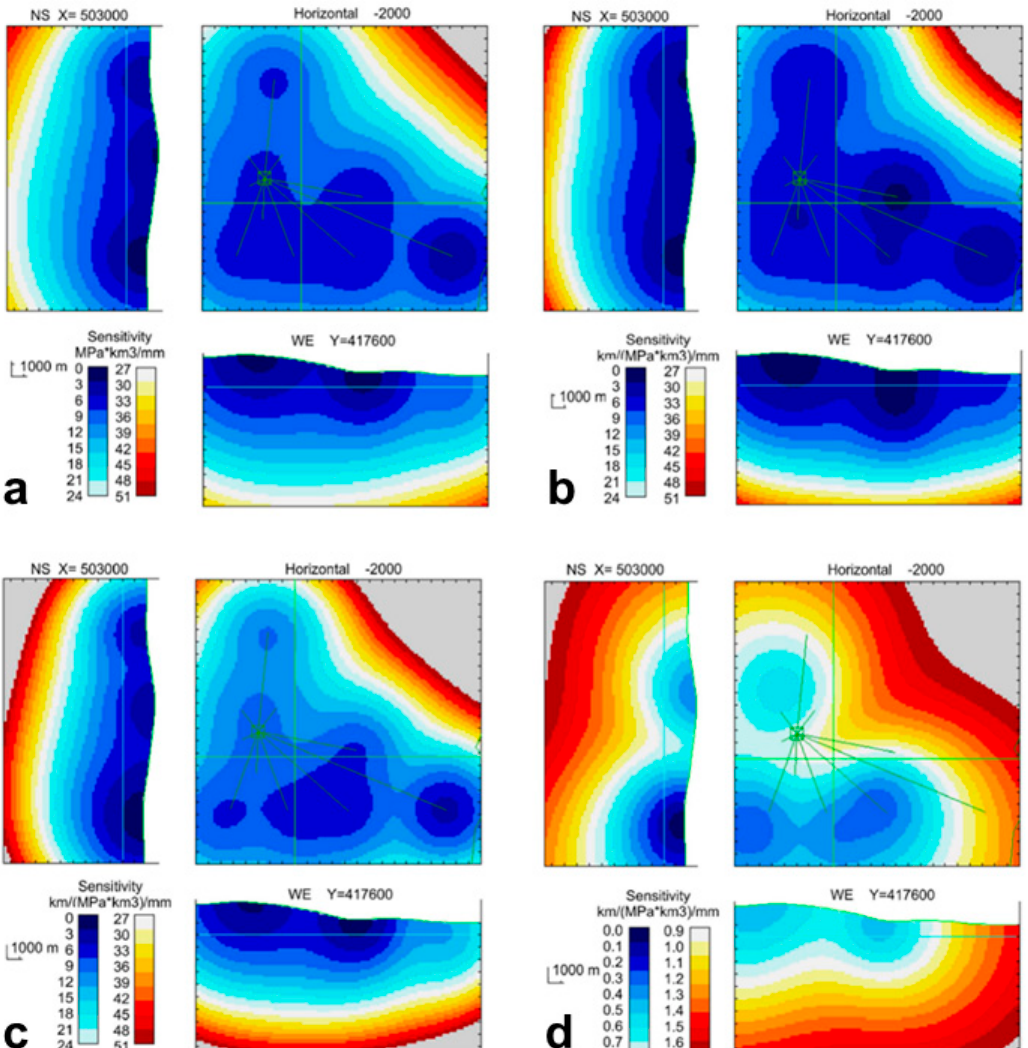
Figure 21. 3D uncertainty maps for the considered GPS network of 10 stations, representing, respectively, ( a ) the pressure changes, ( b ), the depth changes, and ( c ) the horizontal deviations required to produce a surface deformation with quadratic mean value 1 mm. Map ( d ) represents the minimum horizontal deviation for an isolated body of 1 km 3 with a pressure change given in panel ( a ) to produce a deformation at the GPS stations with rms magnitude of 1 mm